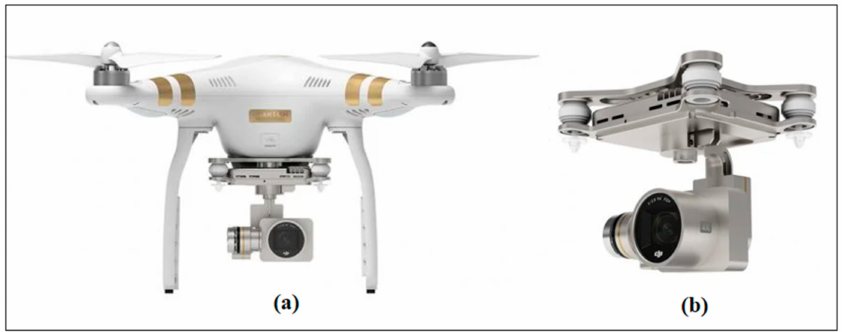
Figure 3. ( a ) The unmanned aerial vehicle (UAV) and ( b ) its built-in digital camera. The UAV aviated automatically according to the predetermined flight rout to record imagery with nearly 80% forward overlapping and 60% side overlapping which are con- trolled by the DJI GO mobile application. Following the images from UAV platform are processed by using the software Agisoft Metashape Profession (Agisoft LLC, ST. Petersburg, Russia) to generate an orthoimage. In this way, the key processing steps of image alignment, camera calibration, georeferencing, construction of dense point clouds and generation of the orthoimage were conducted according to the procedure from Lu et al. [60]. Hence, the process of orthomosaic generation with the use of ground control points (GCPs) was carried out in the software environment. Firstly, in order to automatically align the acquired images using a feature point matching algorithm, individual RGB images and GPS data transferred from the camera to the software environment. Secondly, reference coordinates of camera position were used to georeferencing of images and then, the alignment of images had been checked in the total of 12 locations by using ground control points. The camera internal parameters were also estimated by using the image alignment information and reference positions with Brown’s lens distortion model used in Agisoft Metashape [61]. Thirdly, in the build dense cloud dialog box the desired reconstruction parameter of depth filtering had been chosen as mild. It was due to the sharp and small canopy of crop residue [62]. Finally, the digital elevation model (DEM) and orthoimage with a spatial resolution of 5 cm were generated with default parameters and exported as a TIFF image format for subsequent analysis. More detailed information about the orthoimage processing based on Agisoft Metashape software could be seen in [61]. This study was carried out based on the direct use of digital numbers (DN) of orthoimage (see: [48,60,62]). We downloaded a Sentinel-2 MSI Level-1C (Top-of-Atmosphere reflectance) remotely sensed image acquired on 16 November, 2019 from Copernicus Open Access Hub (https: //scihub.copernicus.eu/ (accessed on 2 March 2021)). Table 1 shows the spectral bands of the Sentinel-2 satellite imagery. Atmospheric correction for the imagery was conducted by using the Sen2cor atmospheric correction toolbox in the Sentinel Application Platform (SNAP) software. In order to classify the purposes, totally, the number of ten bands (2–8, 8A, 11 and 12) were clipped to the study